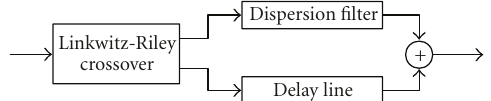
Figure 5: Block diagram showing generic structure used to produce straightened